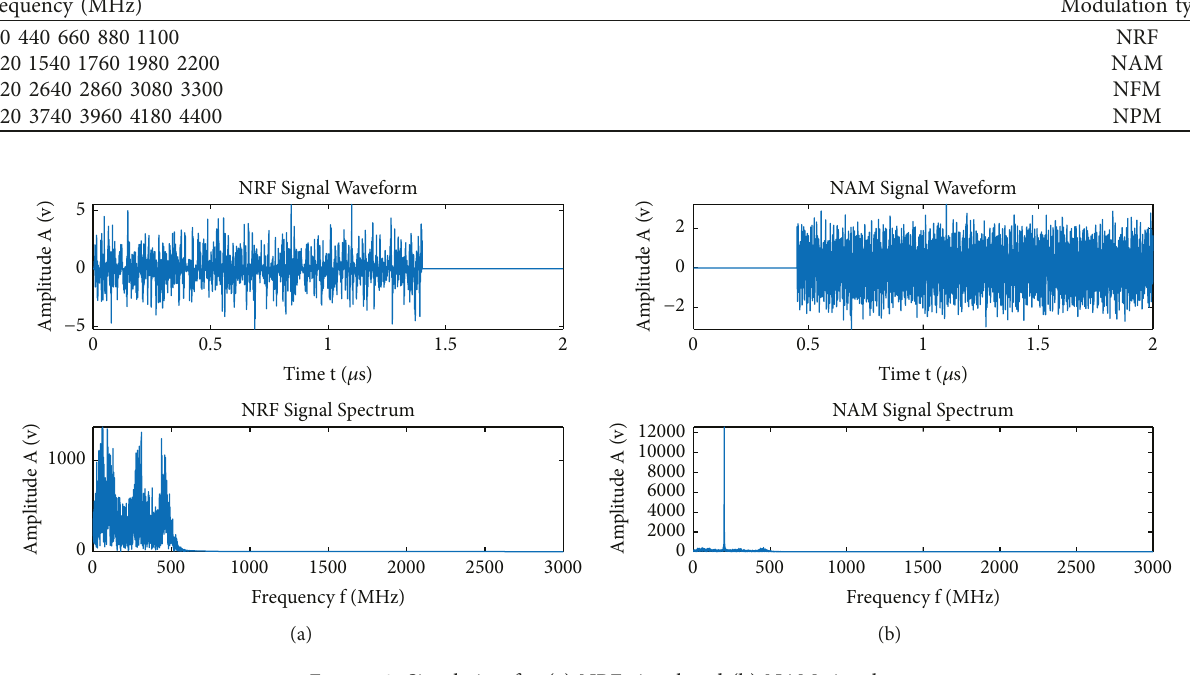
Figure 3: Simulation for (a) NRF signal and (b) NAM signal. Table 4: Elements of EM signal with four complexity